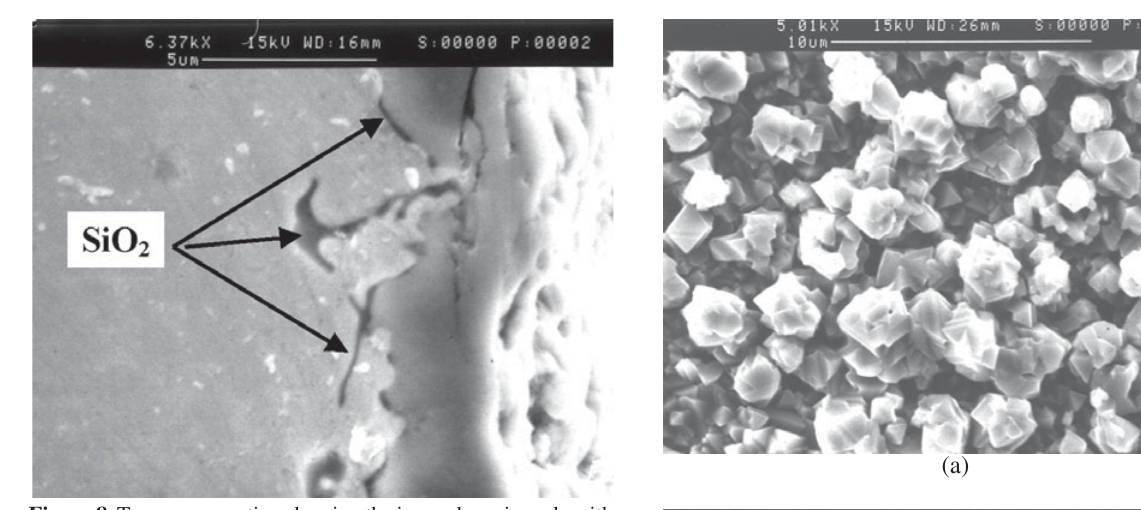
Figure 8. Transverse section showing the inner chromia scale with silica at the bottom (dark zones). Oxidation of 304 steel for 50 h at 950 °C in O . 2